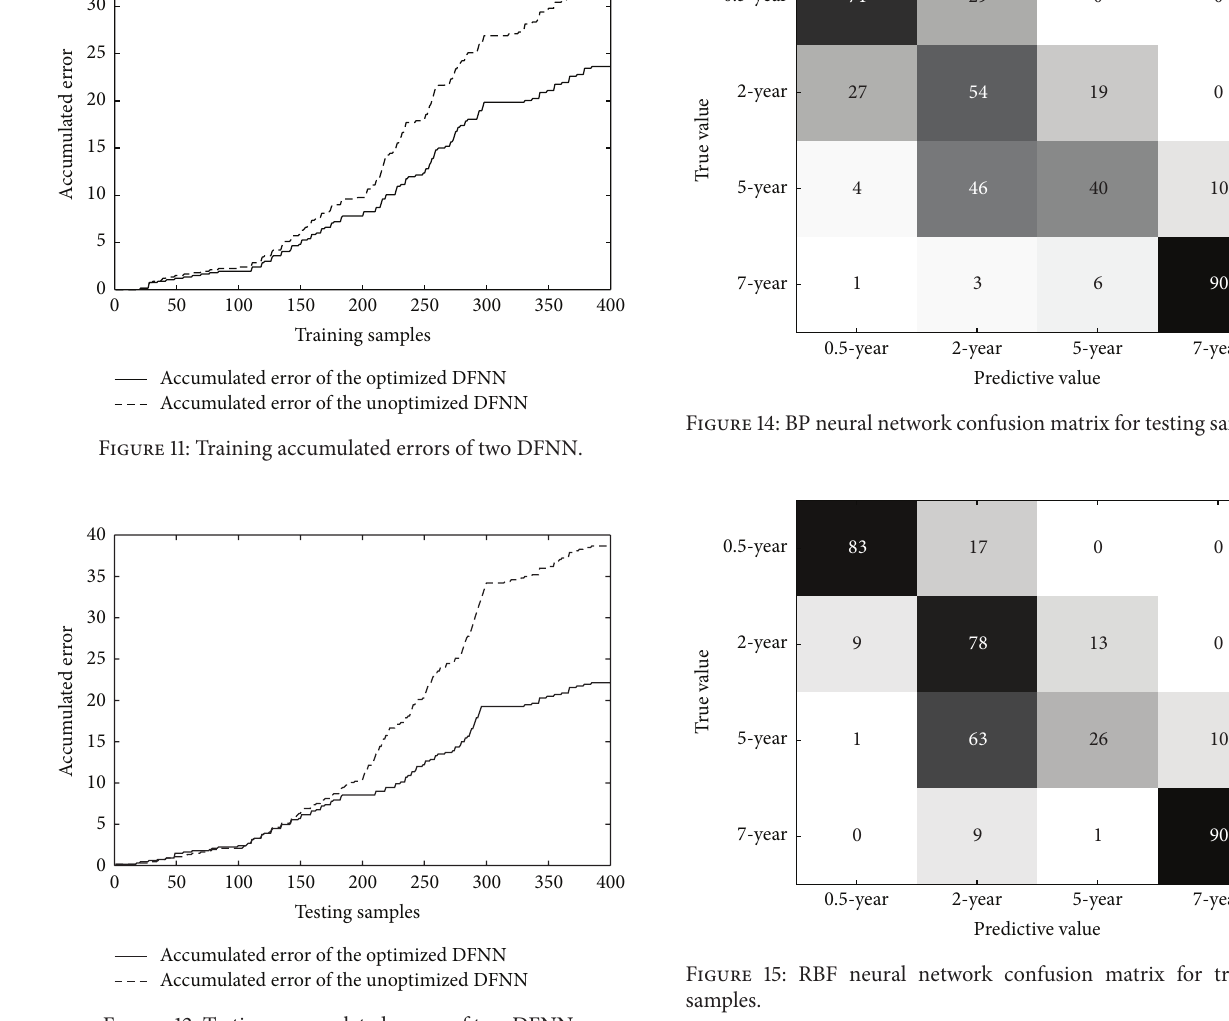
Figure 12: Testing accumulated errors of two DFNN.